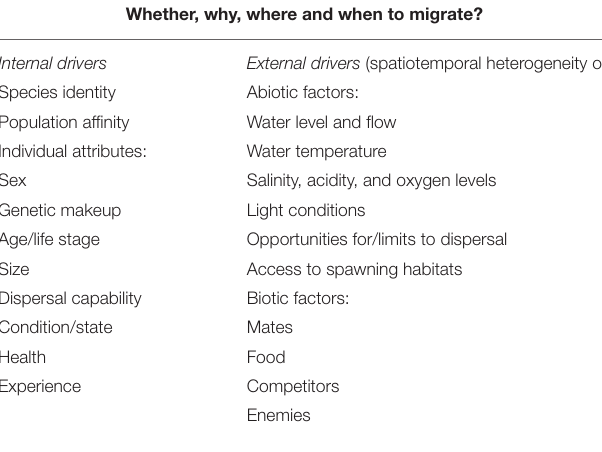
TABLE 1 | Overview of potential correlates and putative internal (left column) and external (right column) drivers of variation and flexibility in migration behavior in